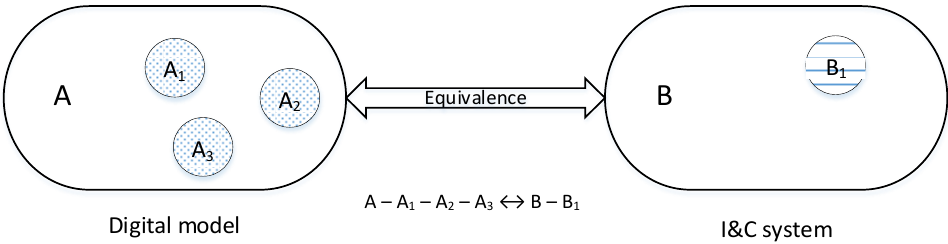
Figure 3. The equivalence of the I&C systems and its digital model. The part of the I&C system that is not covered with the model is shown as a set B 1 ; the model components that have not counterparts in the real system are shown as sets A 1 , A 2 , A 3 .